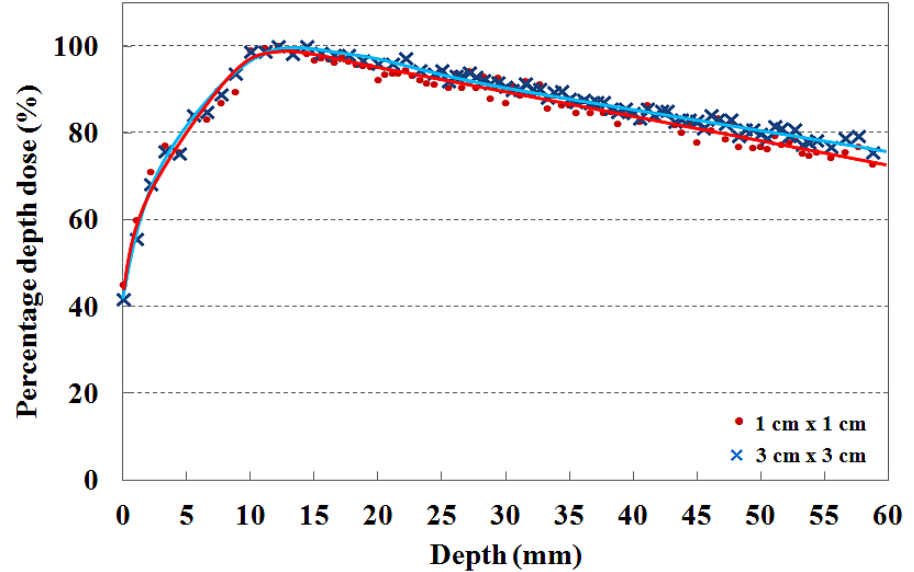
Figure 6. Measurement of percentage depth doses with 1 × 1 and 3 × 3 cm 2 field